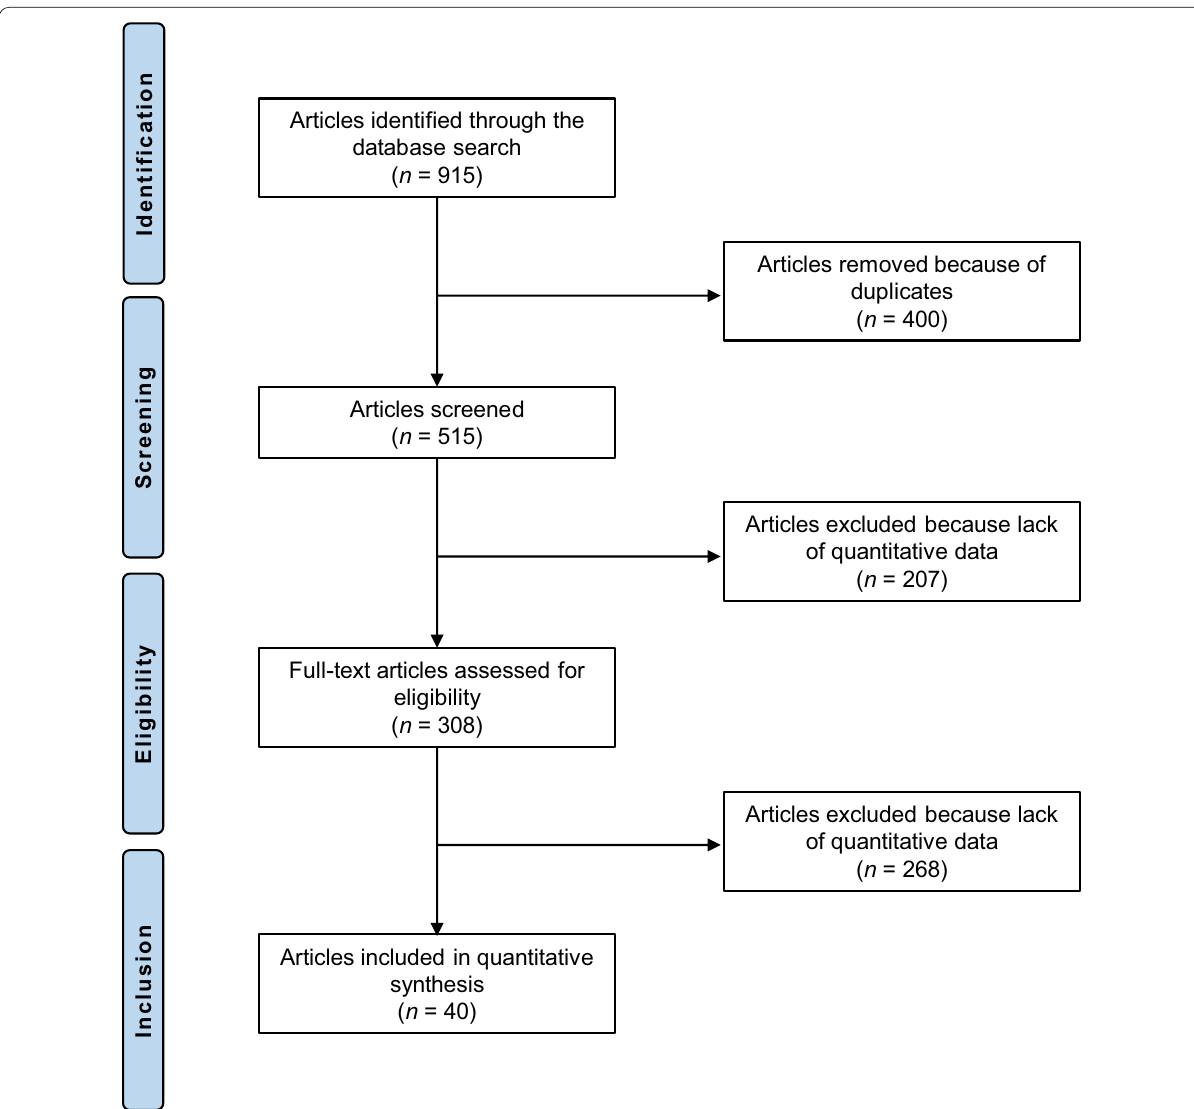
Fig. 1 Flow chart of the literature